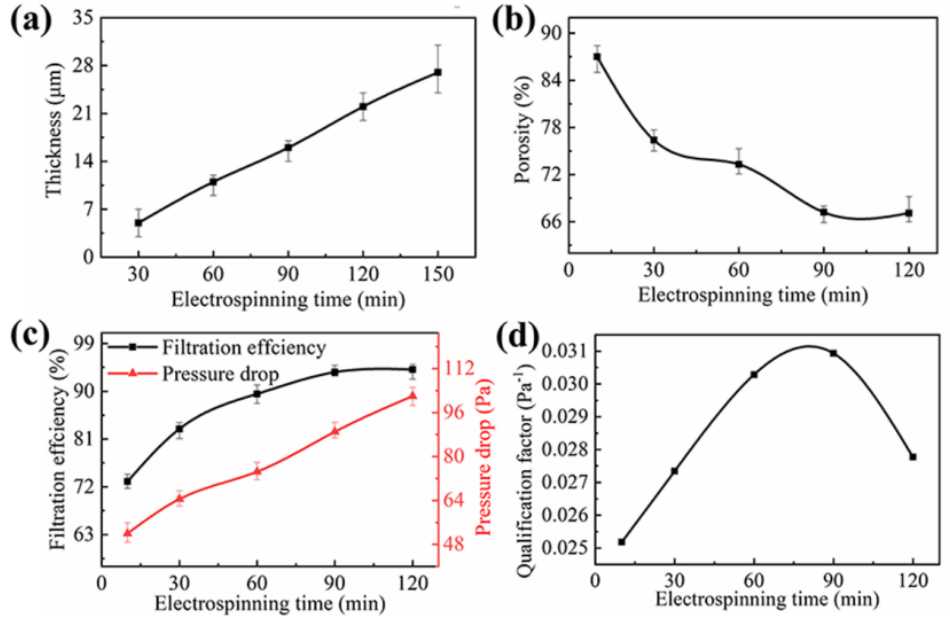
Figure 8. ( a ) The thickness of PVDF nanofiber membrane with electrospinning time. ( b – d ) The porosity, filtration efficiency and pressure drop, QF of PVDF nanofibrous membrane at different electrospinning time, respectively. The distances between electrode and collector, the voltage and the roller speed were 3.0 cm, 5 kV and 600 rpm, respectively.